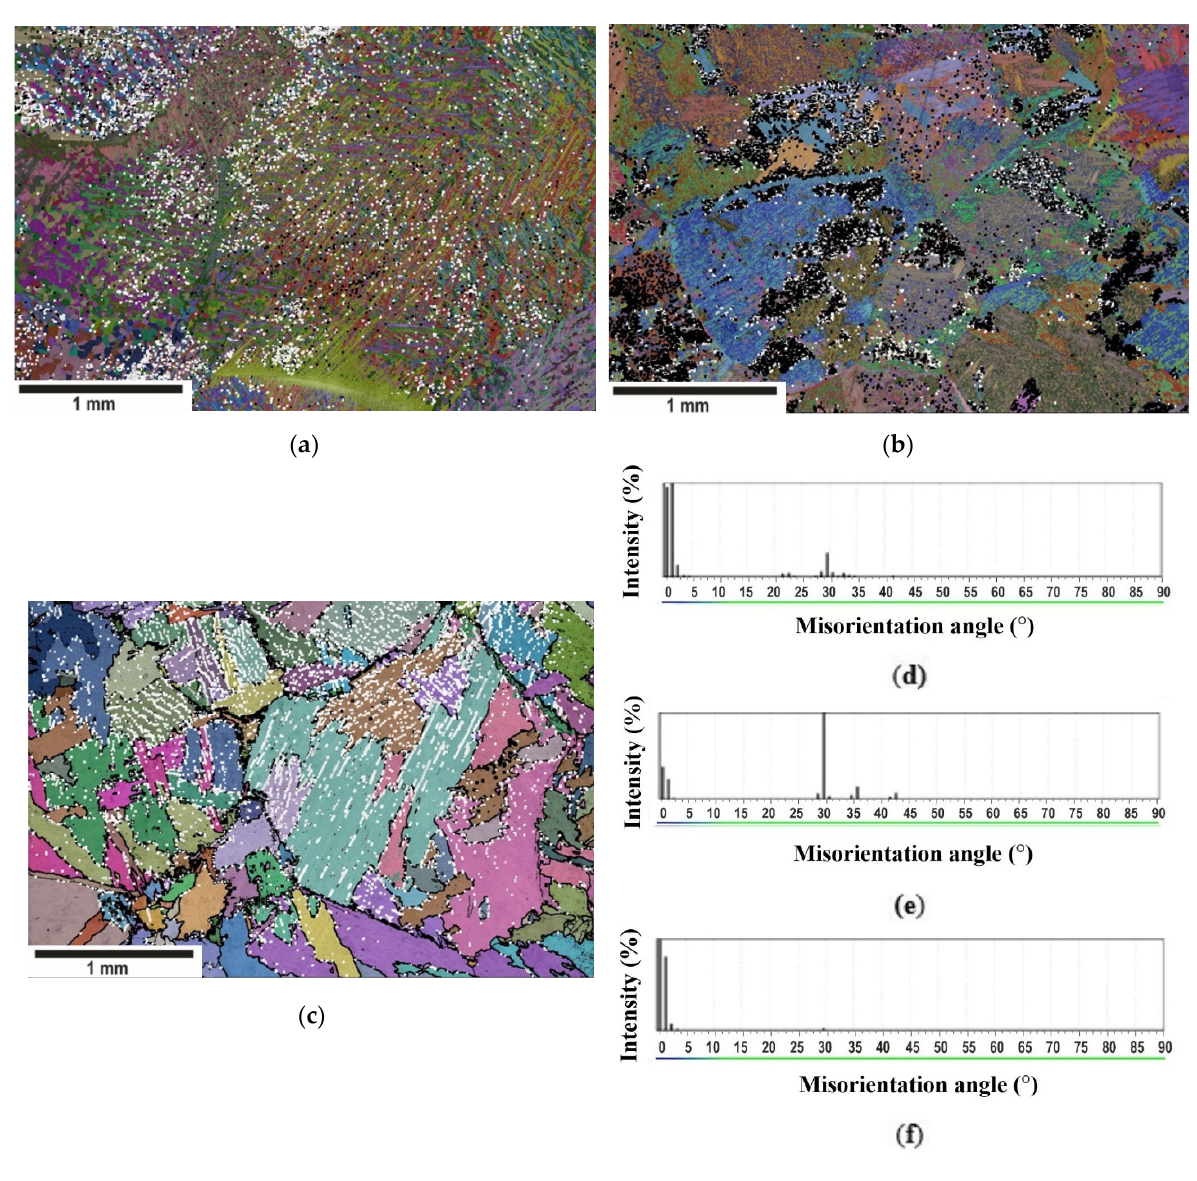
Figure 3. Phase maps with the identification of BOR at the α - β -interphase boundaries for: ( a ) WQ , ( b ) AC , ( c ) FC samples ( α -phase—superimposed band contrast and Euler angles; β -phase—white; black color characterizes the α / β -boundaries deviated from BOR); Spectra of deviation from BOR for: ( d ) WQ , ( e ) AC , ( f ) FC samples.